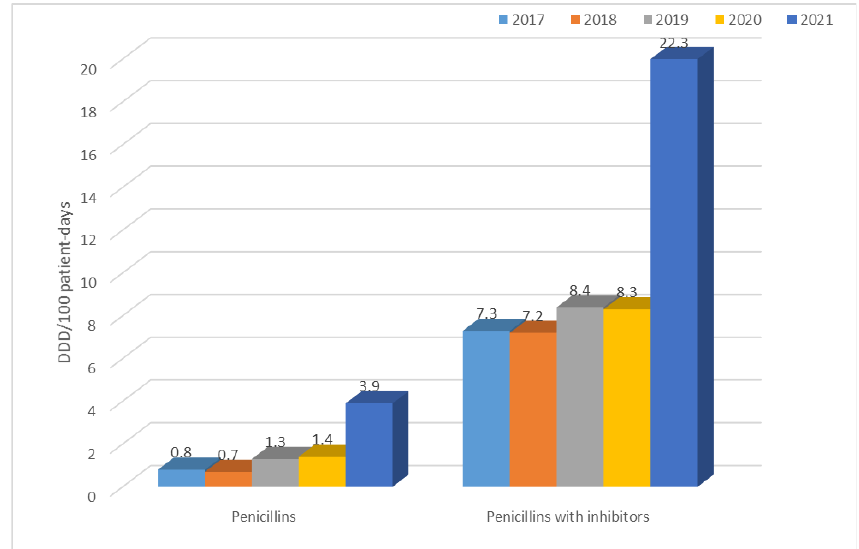
Figure 26. Consumption of penicillins (ampicillin) and penicillins with inhibitors (amoxicillin with clavulanic acid, ampicillin with sulbactam, and piperacillin with tazobactam) in 2017–2021. For other antibiotics used in the treatment of Enterobacteriaceae infections, such as fourth-generation cephalosporins, aminoglycosides, tetracyclines, polymyxins, or cotri-